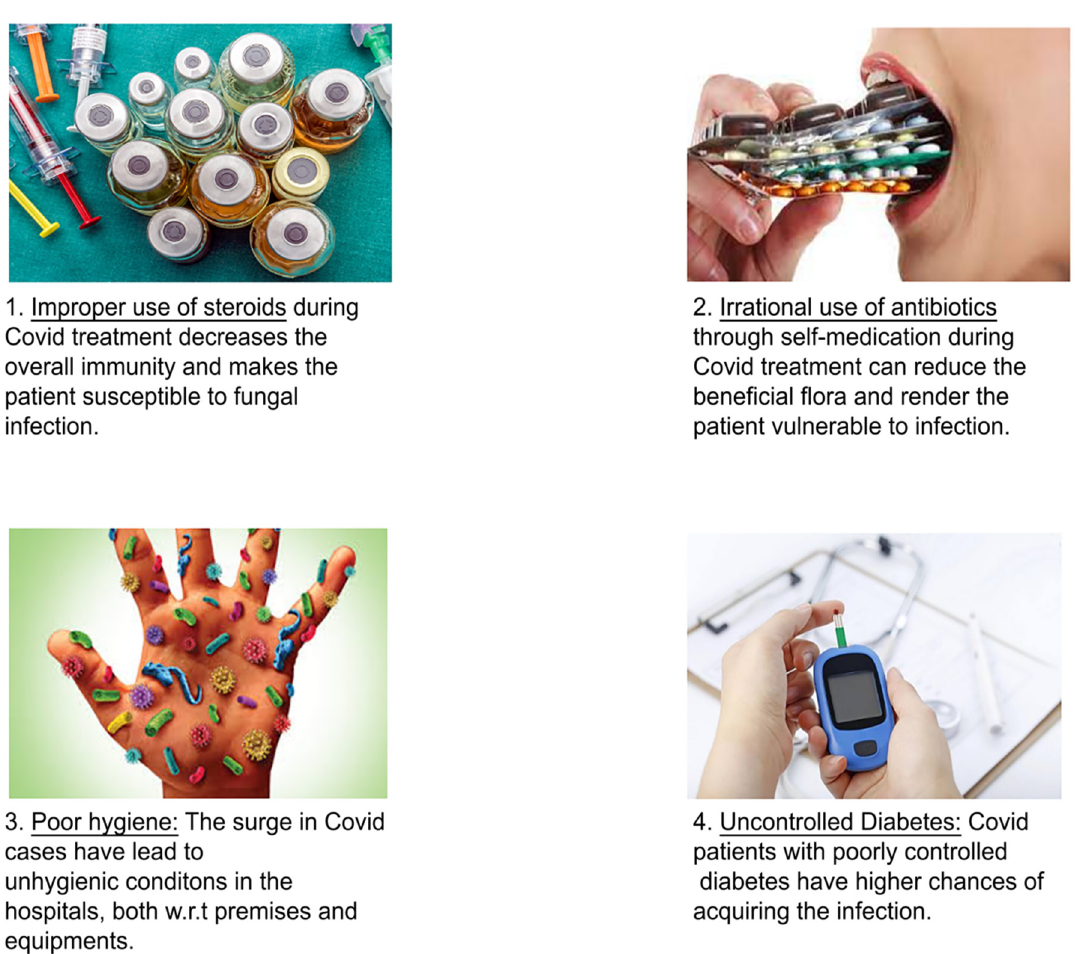
Figure 8. Plausible reasons for COVID patients to acquire black fungus